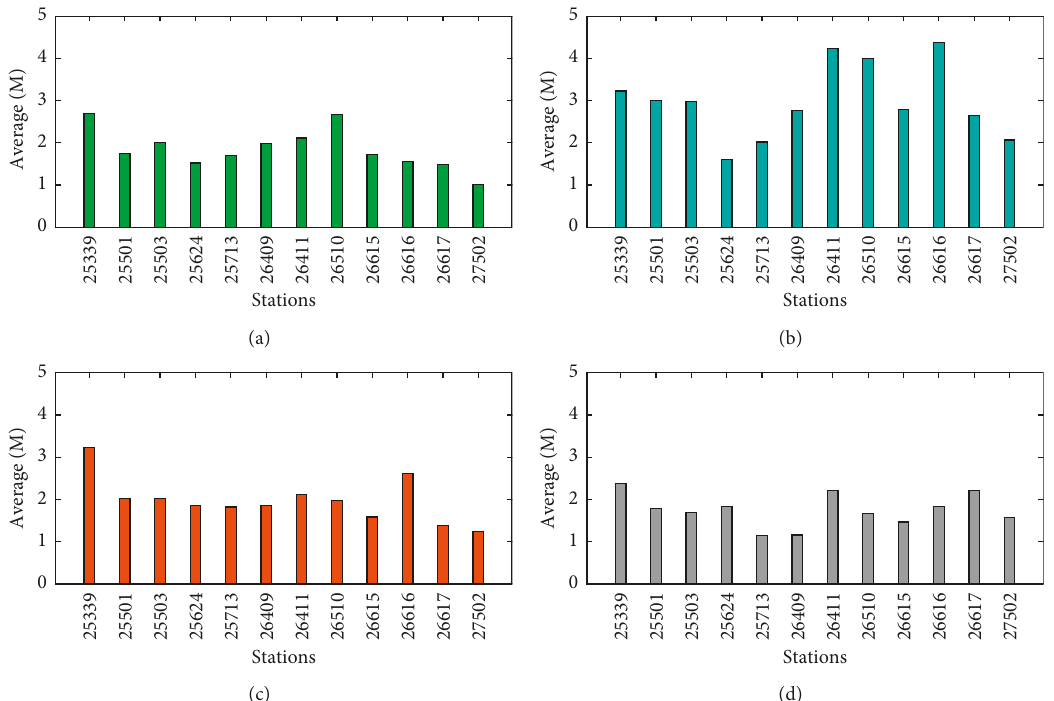
Figure 8: Seasonal average intensity (M) distributions of surface ducts at 12 stations in Alaska: (a) spring; (b) summer; (c) autumn; (d)